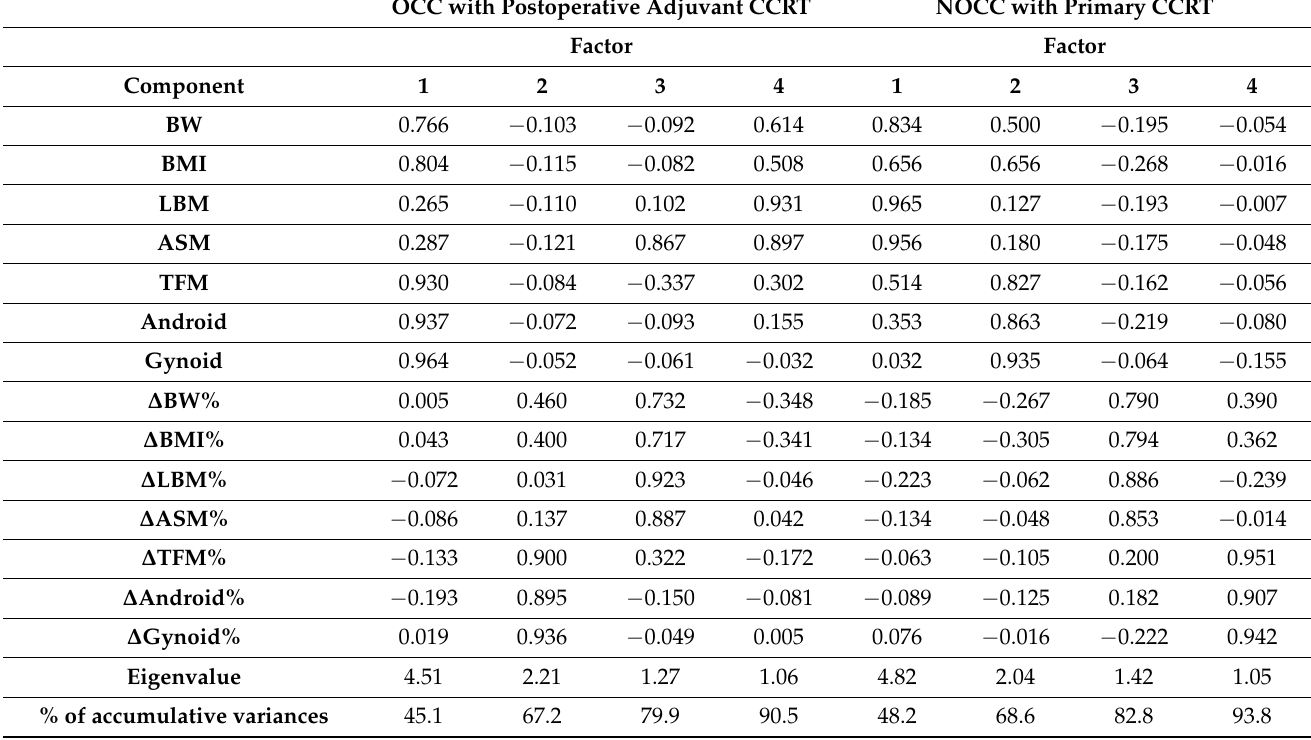
Table 3. Factor analysis results of BW, BMI, and DXA-related parameters of 69 patients with OCC treated with postoperative adjuvant CCRT and 54 patients with NOCC treated with primary